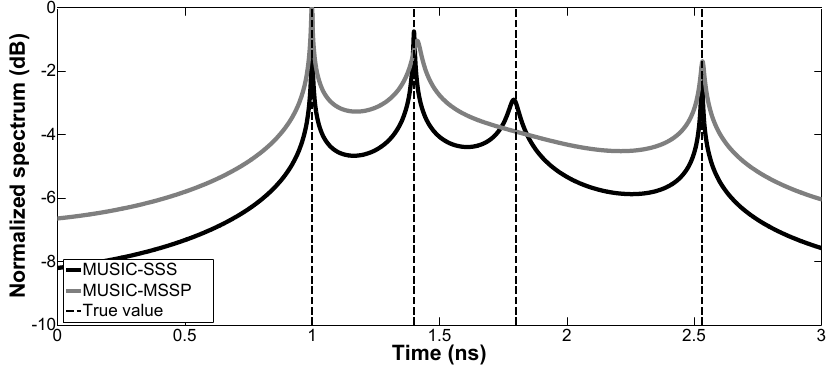
Figure 2. Case a, pseudo-spectrum of MUSIC-SSS and MUSIC-MSSP for TDE with SNR = 10 dB.